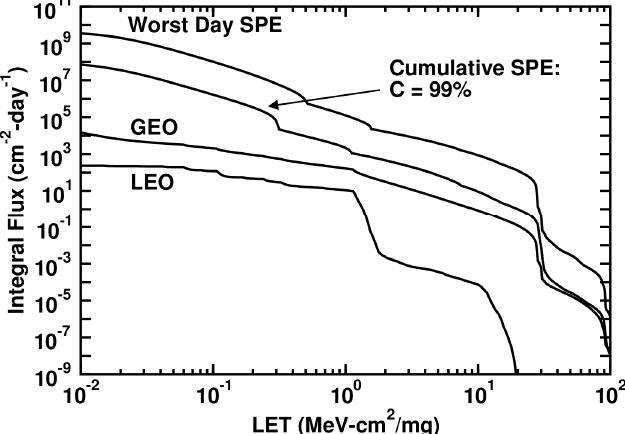
Figure 2. Worst day solar particle event (SPEW) from CREME96 [18]. GEO and LEO are solar minimum spectra from CREME96 [18]. Cumulative solar particle event spectra at the 99% confidence levels after Xapsos et al. [17]. Results for 100 mils aluminum shielding. GEO—geostationary orbit, often referred to as a geosynchronous equatorial orbit (GEO); LEO—low Earth orbit, common usage in discussing satellites.